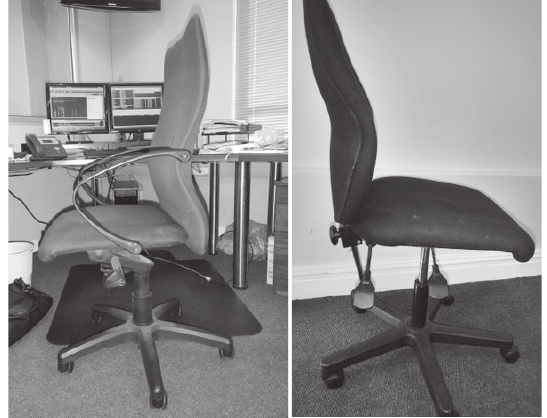
Above left: Figure 1a. Above right: Figure 1b Figure 1: Photographs of chairs used in the study; 1a-Participant 1’s own chair; 1b-Participant 2’s own